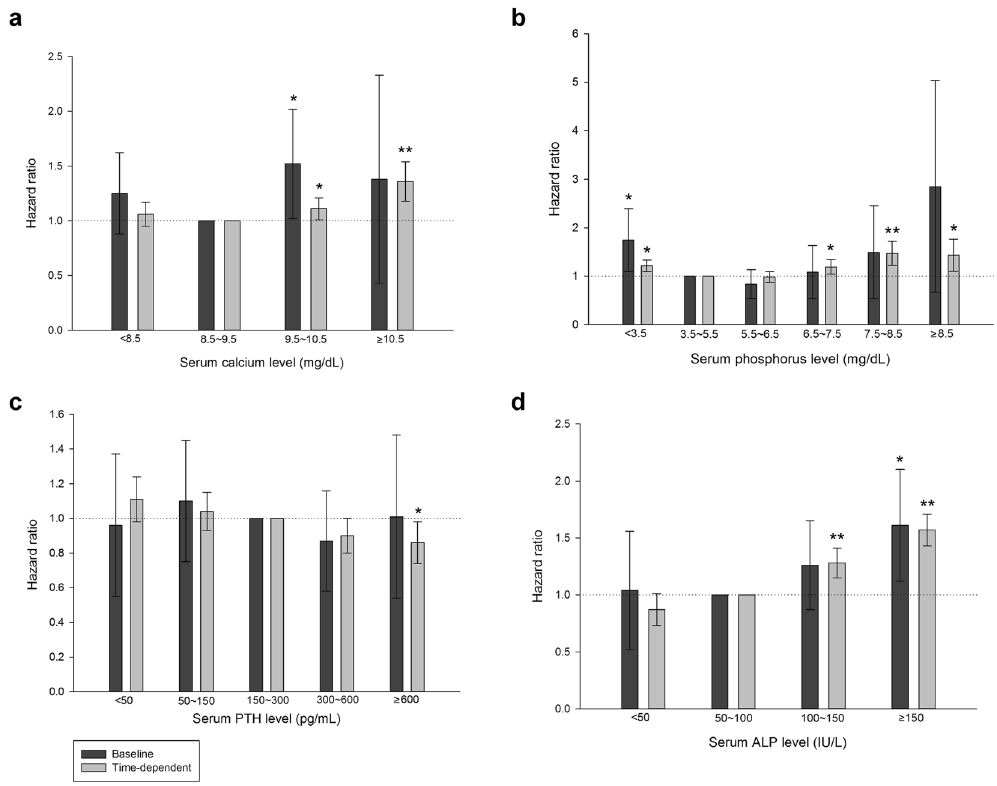
Figure 1. Cox proportional model showing the hazard ratios of CKD-MBD biomarkers to all-cause mortality in patients on peritoneal dialysis in Taiwan. Cox proportional regression model was adjusted for age, gender, diabetes mellitus, Kt/V, albumin, haemoglobin and renal creatinine clearance. Renal creatinine clearance was not included in the time-dependent analysis due to large number of missing baseline values (n = 1879). ( a ) Grouped by serum calcium levels ( b ) Grouped by serum phosphorus levels ( c ) Grouped by serum PTH levels ( d ) Grouped by serum total ALP levels. CKD-MBD, chronic kidney disease-mineral bone disorder; PTH, parathyroid hormone; ALP, total alkaline phosphatase. ** p < 0.0001; * p <